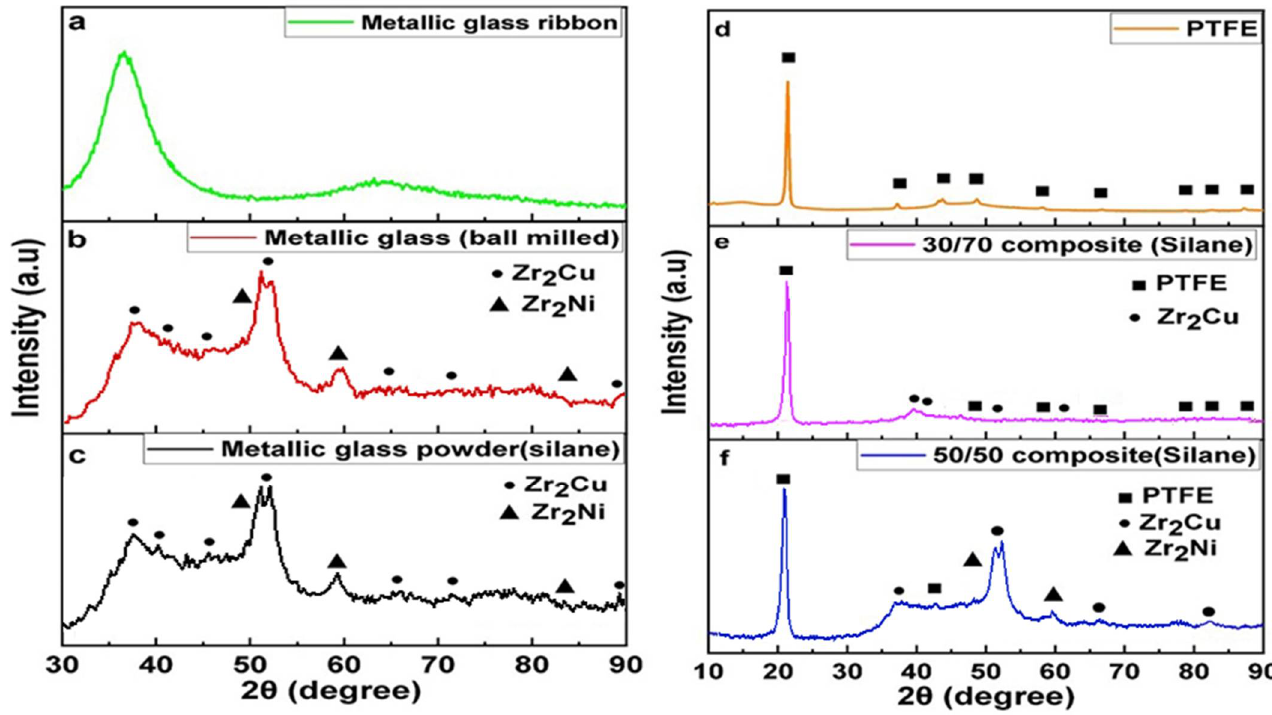
Figure 1. XRD pattern of the ( a ) Zr 65 Cu 17.5 Ni 10 Al 7.5 metallic glass, ( b ) Zr 65 Cu 17.5 Ni 10 Al 7. metallic glass after ball milling at 300 rpm, ( c ) metallic glass powder with silane, ( d ) PTFE polymer, ( e ) 30/70 composite (silane), and ( f ) 50/50 composite (silane).